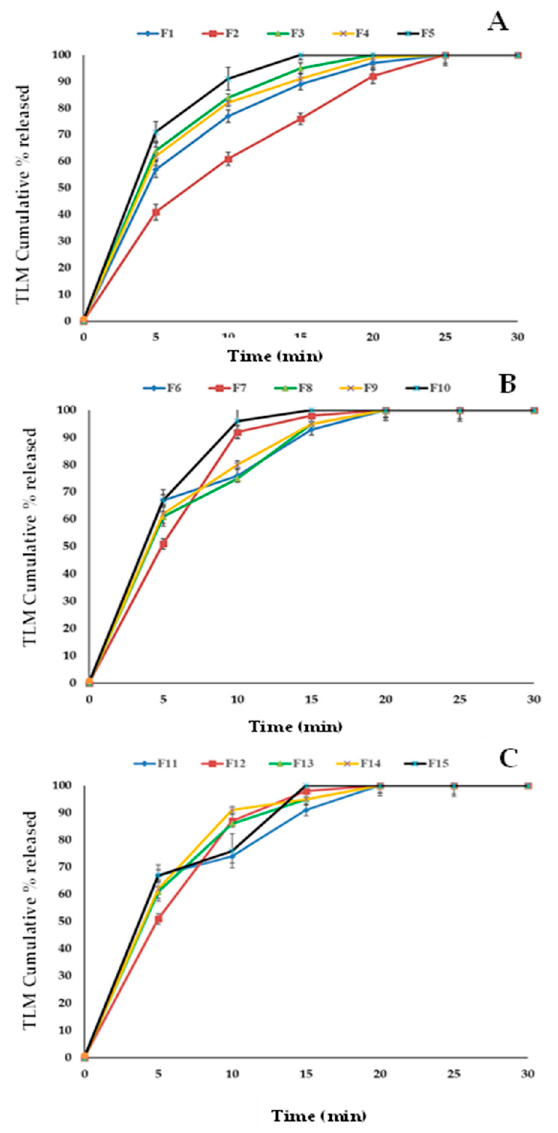
Figure 7. The release profiles of TLM ‐ FDT from different formulations. Release profiles of formu ‐ lae 1–5 ( A ), release profiles of formulae 6–10 ( B ), and release profiles of formulae 11–15 ( C ).